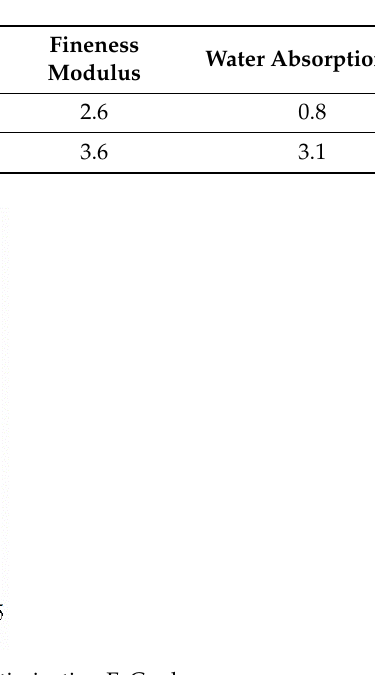
Figure 5. Particle size distribution of FeCr slag and Optimization FeCr-slag.